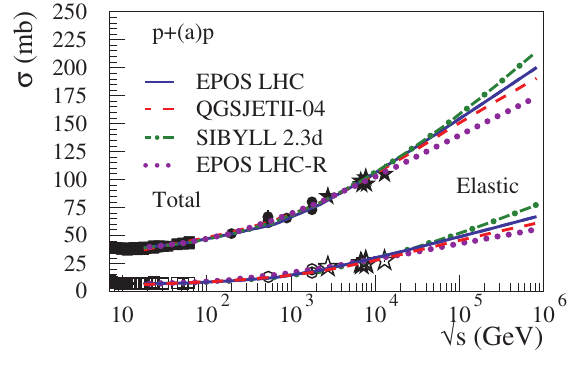
Figure 1. Total and elastic p-p cross sections as a function of center-of-mass energy calculated with E pos LHC-R (dotted line), E pos LHC (full line), QGSJ et II.04 (dashed line), and S ibyll 2.3d (dash-dotted line) predictions. Points are data from [25], and the stars are the LHC measurements [26] including the latest ALFA measurements